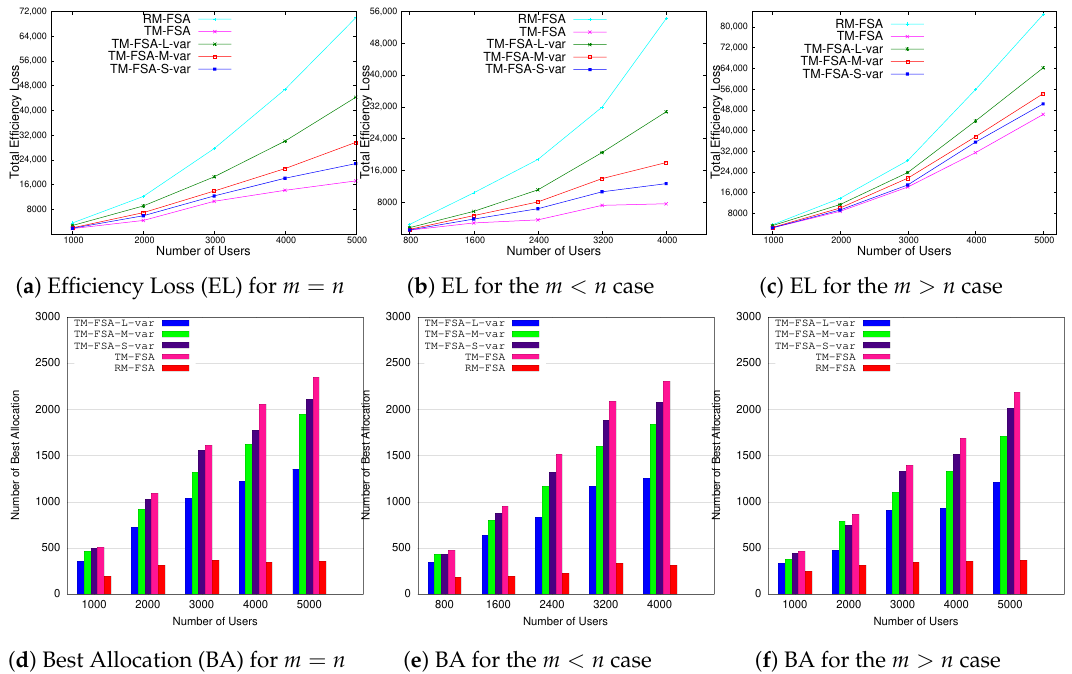
Figure 9. Comparisons of TM-FSA and RM-FSA based on the total efficiency loss and number of best allocation.